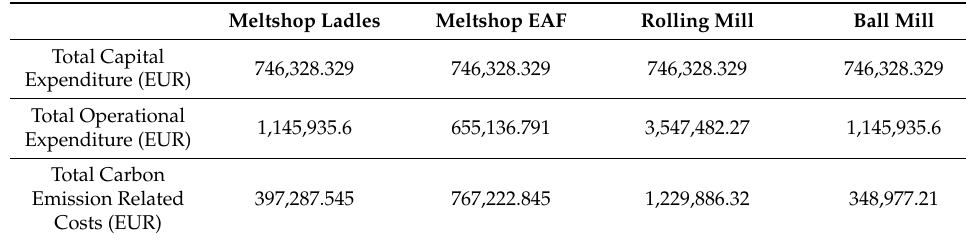
Table 6. Costs for digital tool solutions in euros.